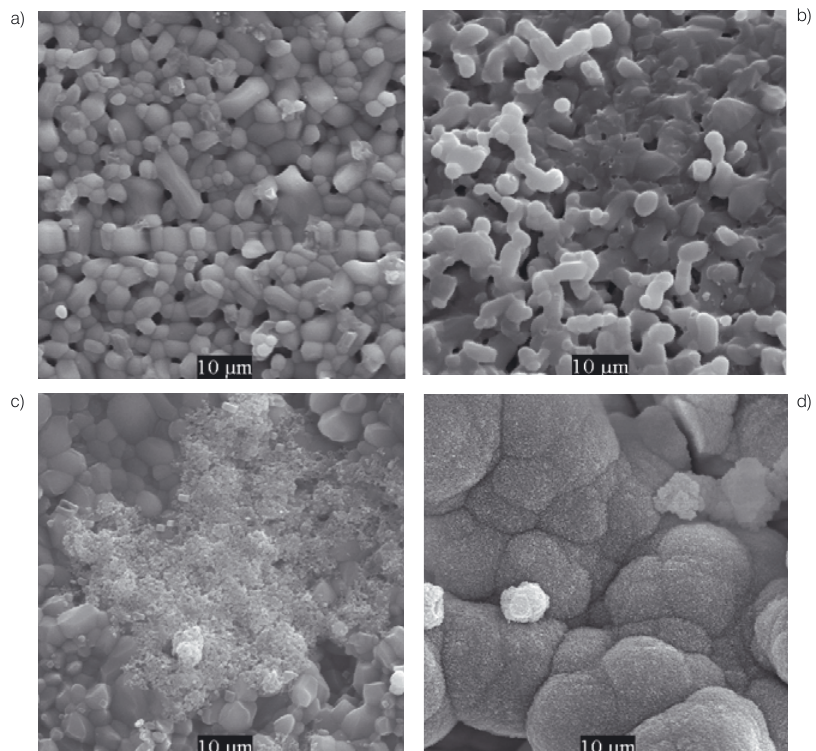
Figure 2. Surface microstructure of FA: a) before immersion in SBF, b) after 48 hours in SBF, c) after 1 week in SBF, d) after 4 weeks in